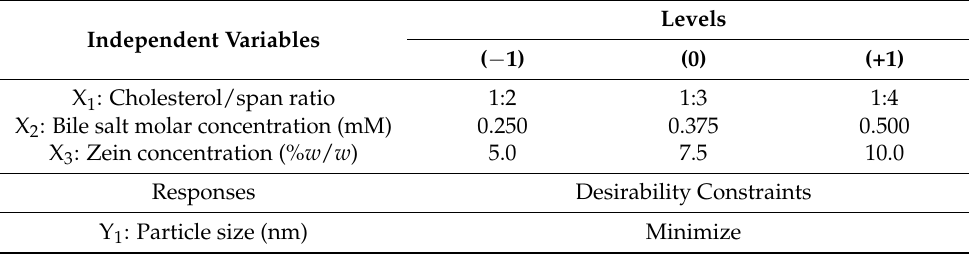
Table 1. Formulation variables’ levels and particle size constraint used in the Box–Behnken design for the formulation and optimization of PIC-BZ. Independent Variables